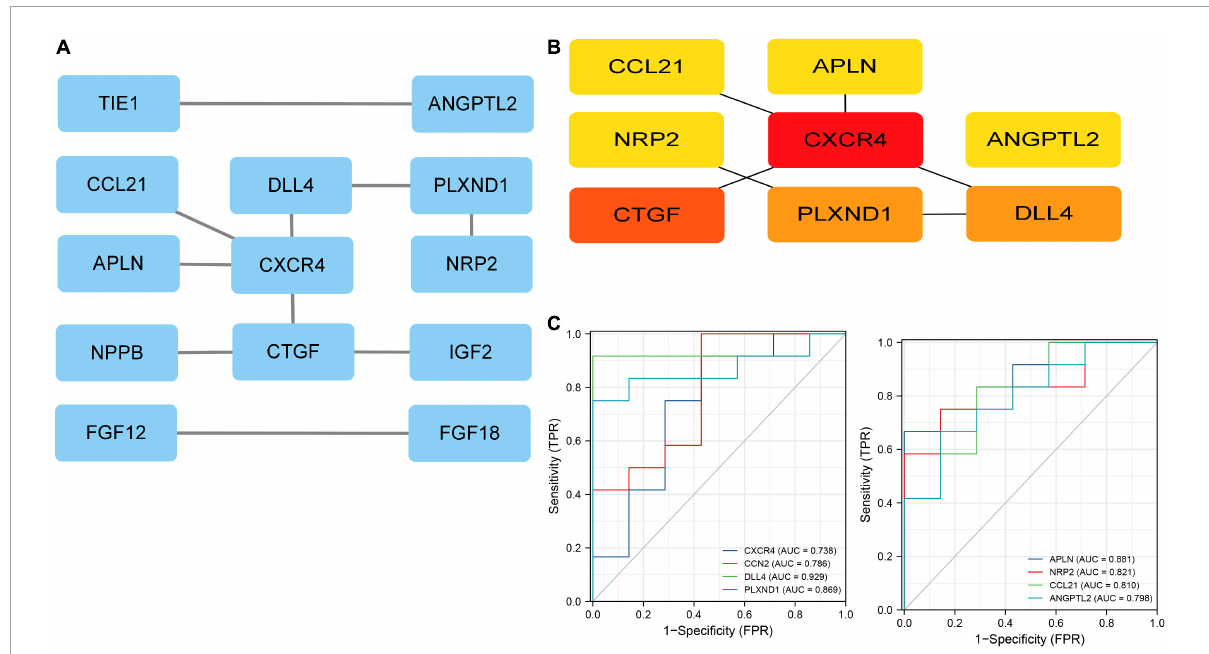
FIGURE4 Protein-protein interaction (PPI) network. (A) The PPI network of 19 immune related DEGs. (B) The top eight genes with the highest connection. (C) ROC curves for eight immune related genes. ROC, receiver operating characteristic.